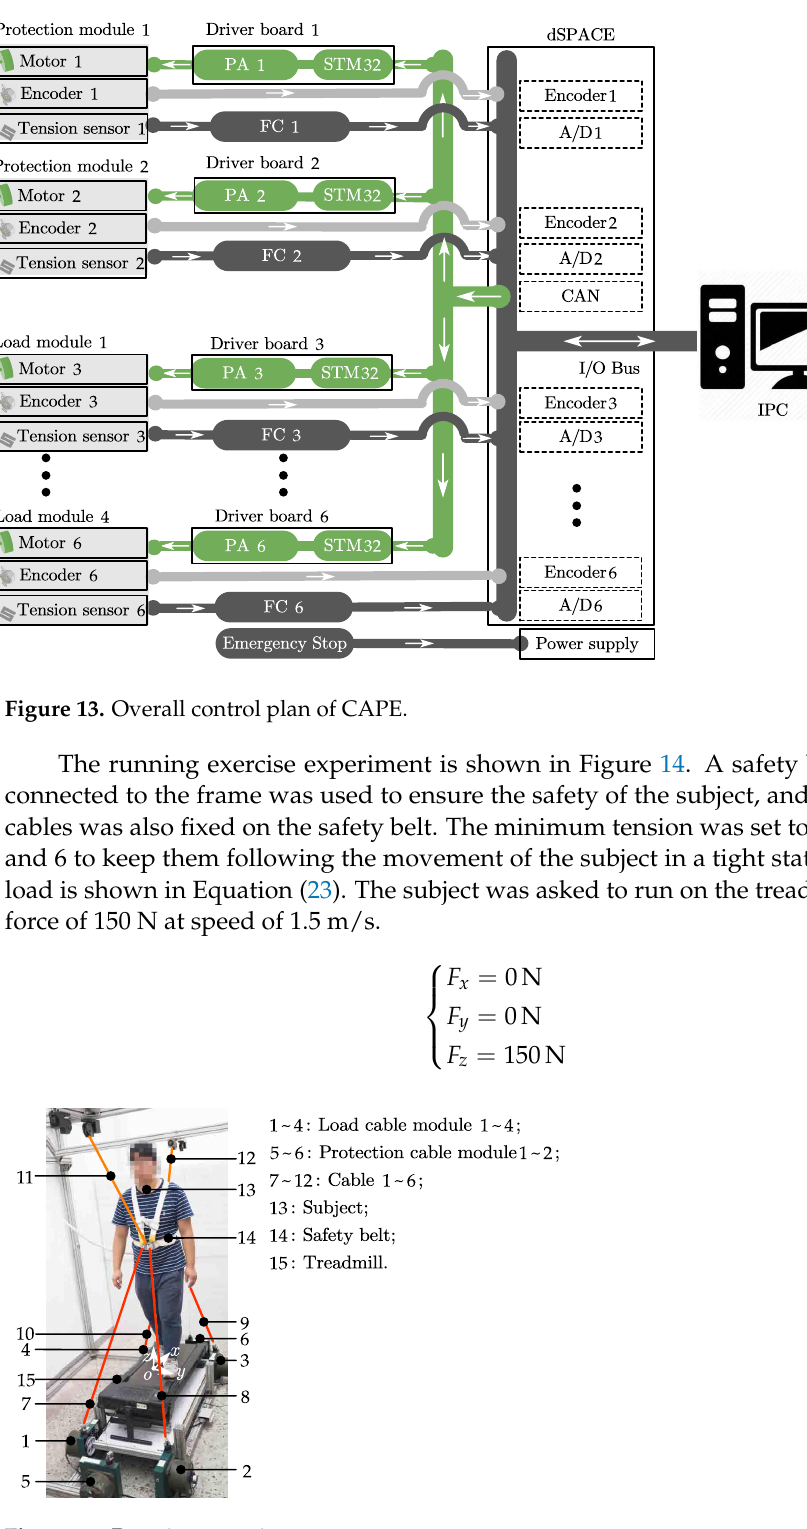
Figure 14. Running